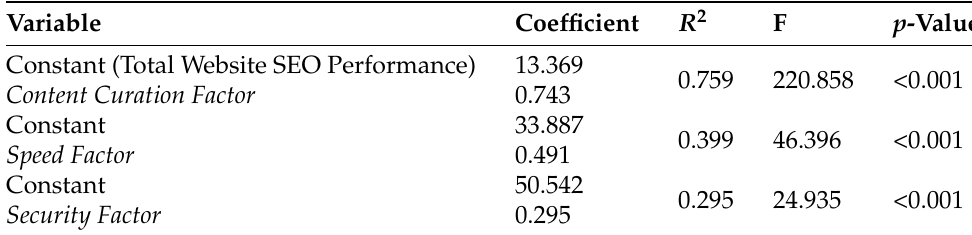
Table 9. Regression equation output of websites with WordPress CMS and their change in each proposed factor.